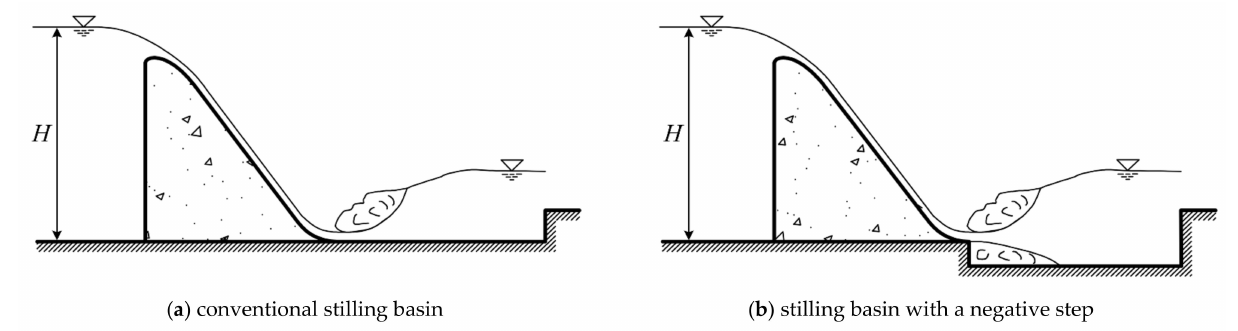
Figure 1. Chart of stilling